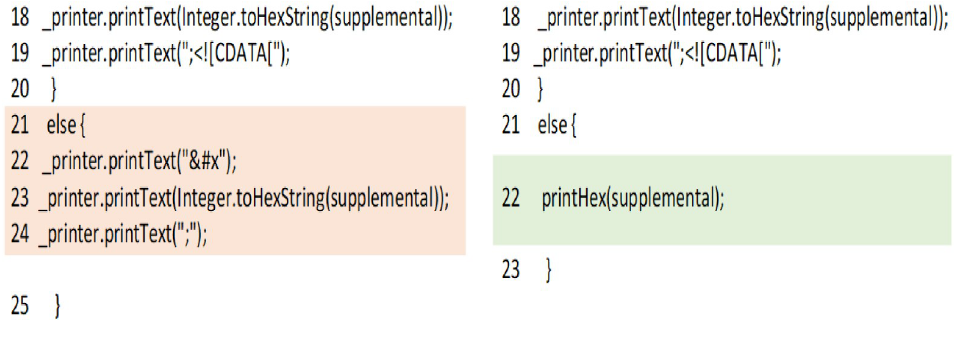
Fig 9. Example of consistent clone refactoring in Xerces_J.